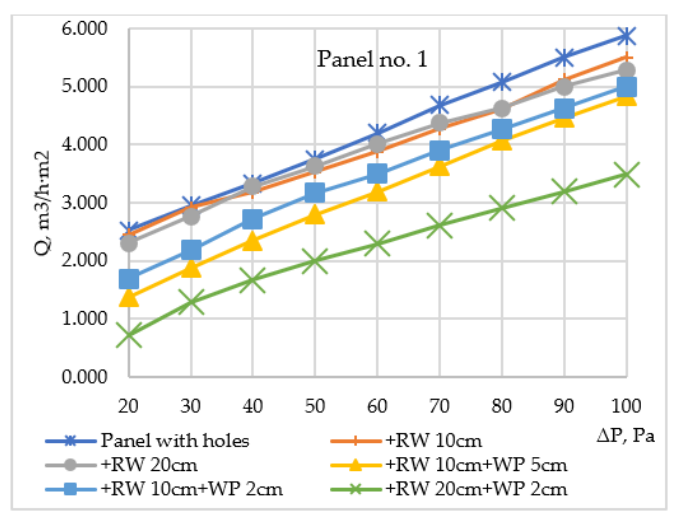
Figure 6. Panel no. 1: air permeability dependence on pressure difference when various insulation variants were applied.